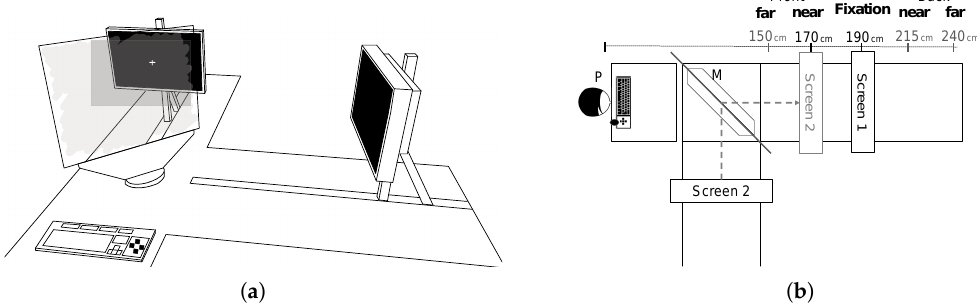
Figure 1. ( a ) Drawing of the experimental setup showing the half-transparent mirror and the two presentation screens in front of the keyboard. ( b ) Scheme of the experimental setup from above. Both screens were adjustable in distance to realize depths as indicated by the scale above. The labels above the scale are the labels used for realized depth planes throughout the paper. During the experiment, one of the two screens (here: Screen 1 which was directly seen through the half-transparent mirror M) was always positioned at the fixation distance of 190 cm. The remaining screen (here: Screen 2 positioned at a distance of 170 cm, which is reflected into the line of sight of the participant P) was positioned at one of the five indicated